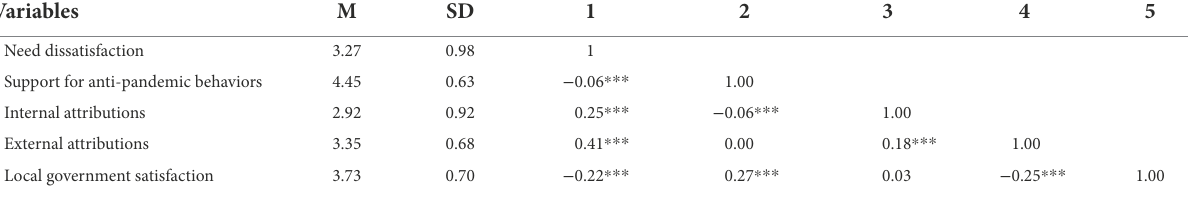
TABLE 2 Preliminary analysis of key variables ( N = 6,022).